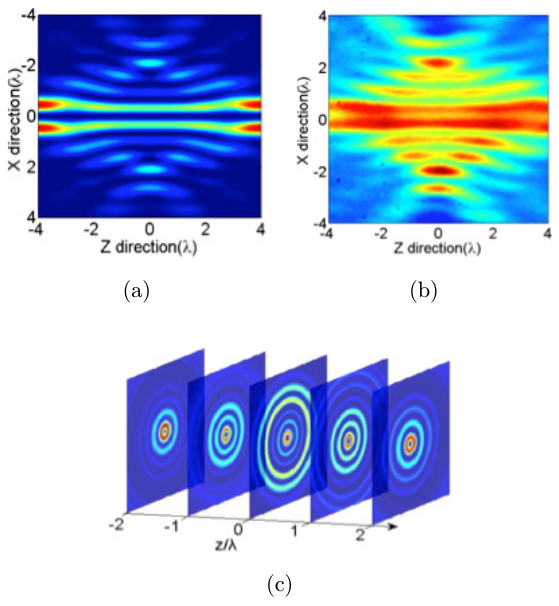
Fig. 3. The electric intensity distribution in the x – z plane after the phase modulation of the binary optics. (a) Calculated result. (b) Experimental result. (c) Cross-sectional of the beam at di®erent positions along z -axis.